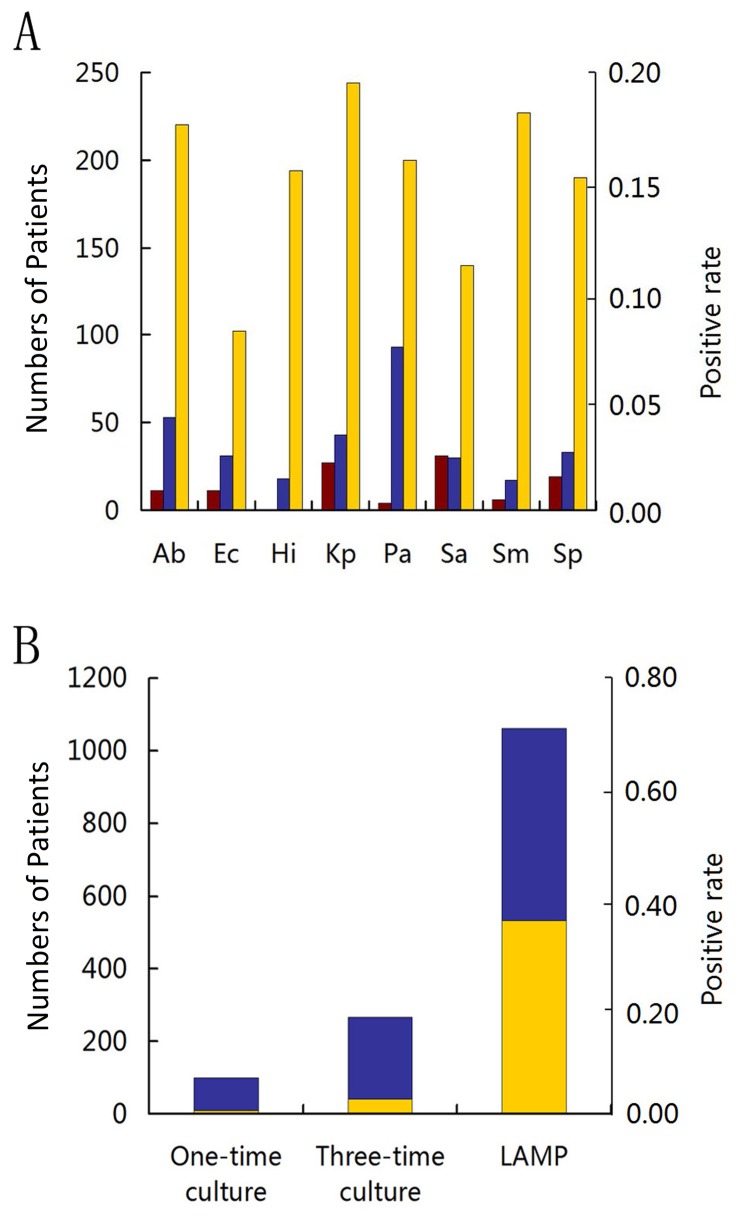
qLAMP and culture result from LRTI patients.(A) The positive rates (the right vertical axis) of one-time culture (brown bar), three-time culture (blue bar), and quantitative LAMP (yellow bar) for the eight species in the panel (from the left: Ab, A. baumannii; Ec, E. coli; Hi, H. influenzae; Kp, K. pneumoniae; Pa, P. aeruginosa; Sa, S. aureus; Sm, S. maltophilia; and Sp, S. pneumoniae) detected from the number of patients (the left vertical axis). (B) The number of patients (the left vertical axis) who were tested positive for at least one bacterium in one-time culture, three-time culture, and qLAMP. Each bar is the sum of patient with single (blue bar) and multiple (yellow bar) species detected.